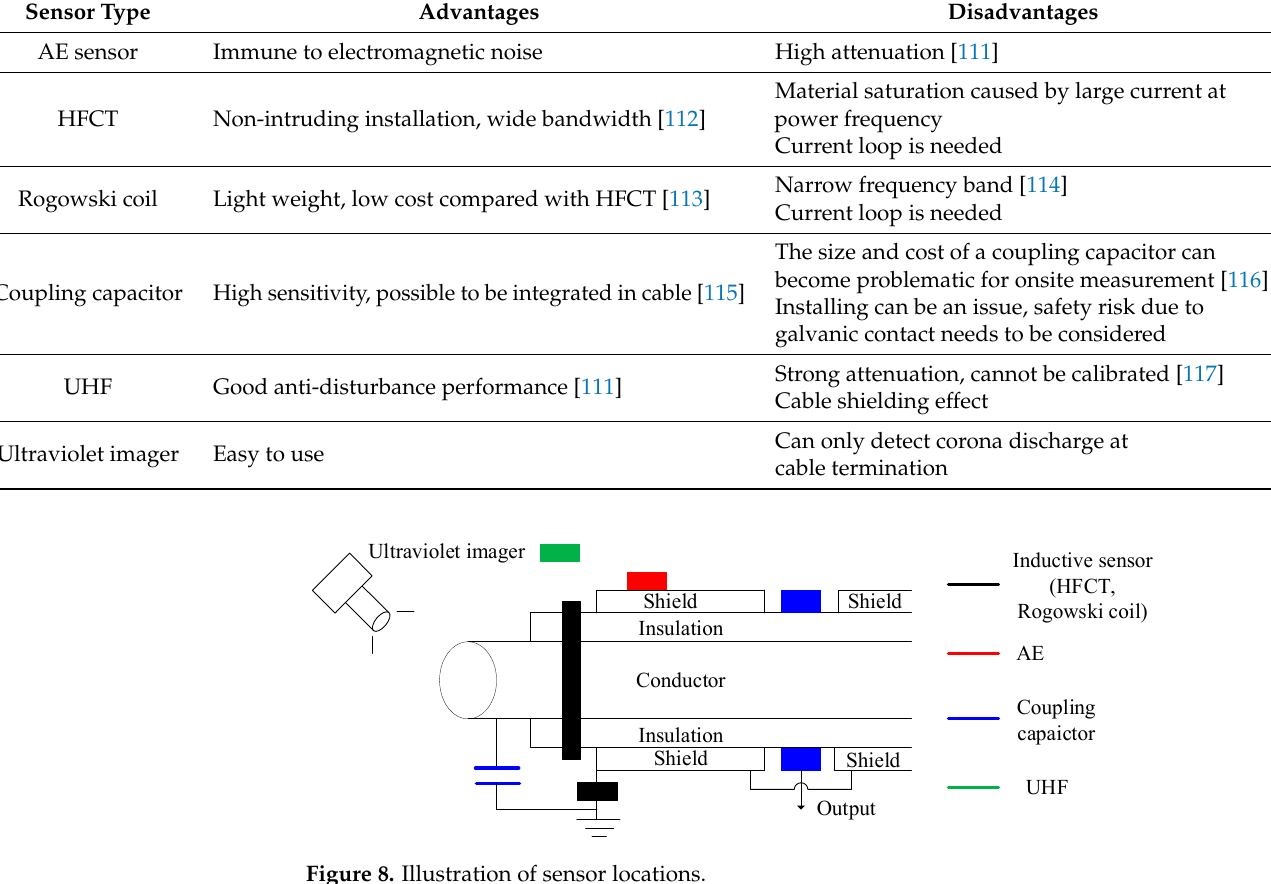
Table 4. PD sensors with advantages and disadvantages.